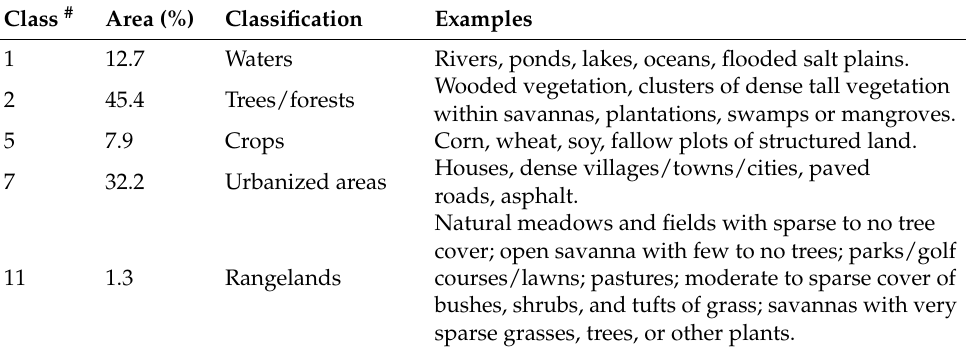
Table 1. Land (vegetation) cover classification schema.